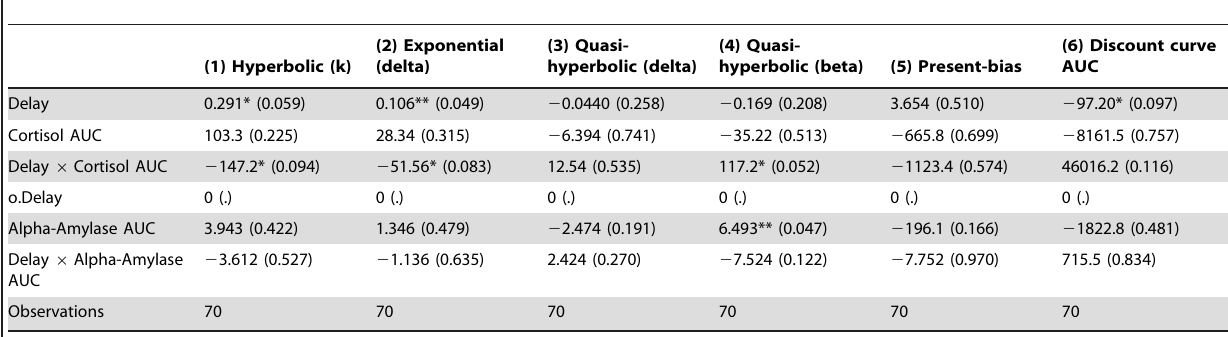
Table 5. Effect of hormonal reactivity to stress on time preference model parameters in the Stress groups.